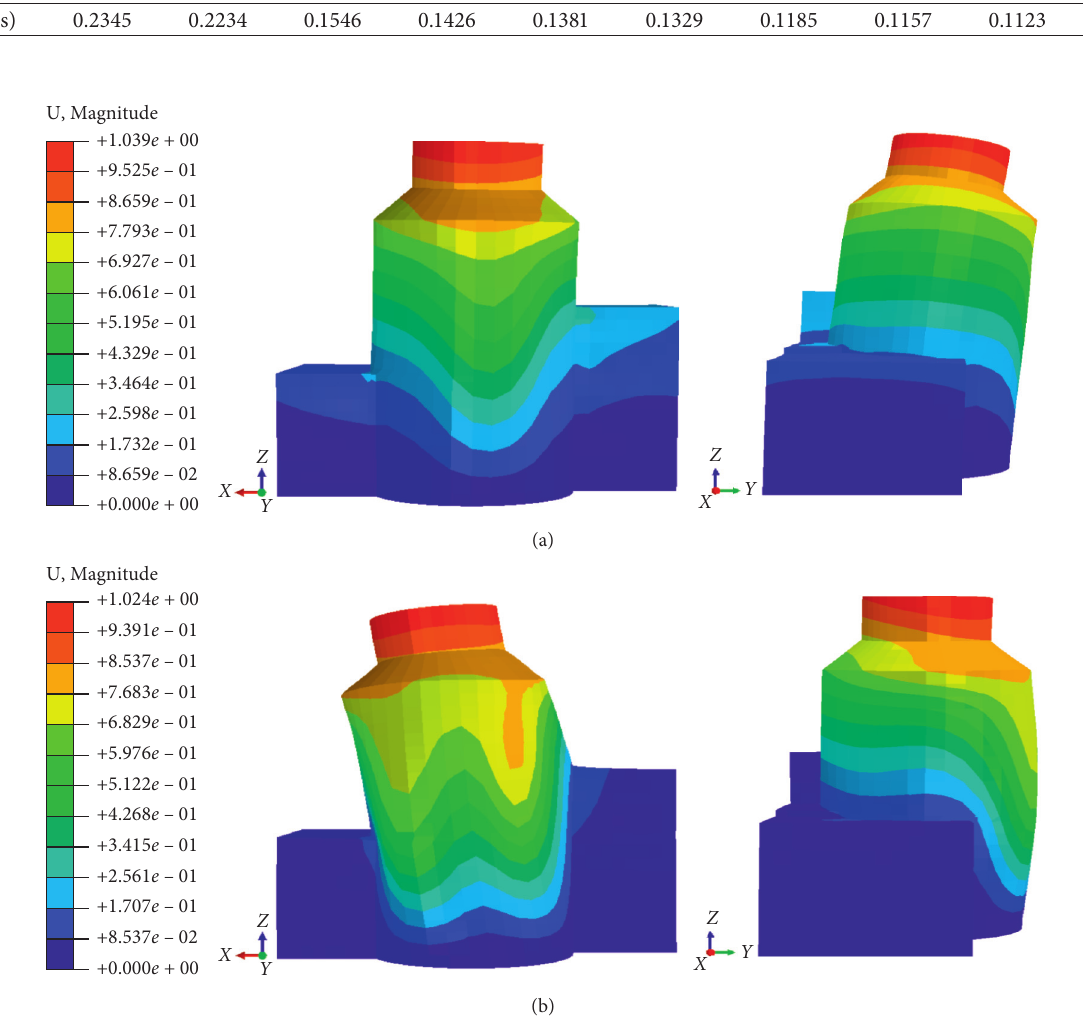
Figure 3: The first two modes of CAP1400 nuclear island structure. (a) The 1st modal. (b) The 2nd